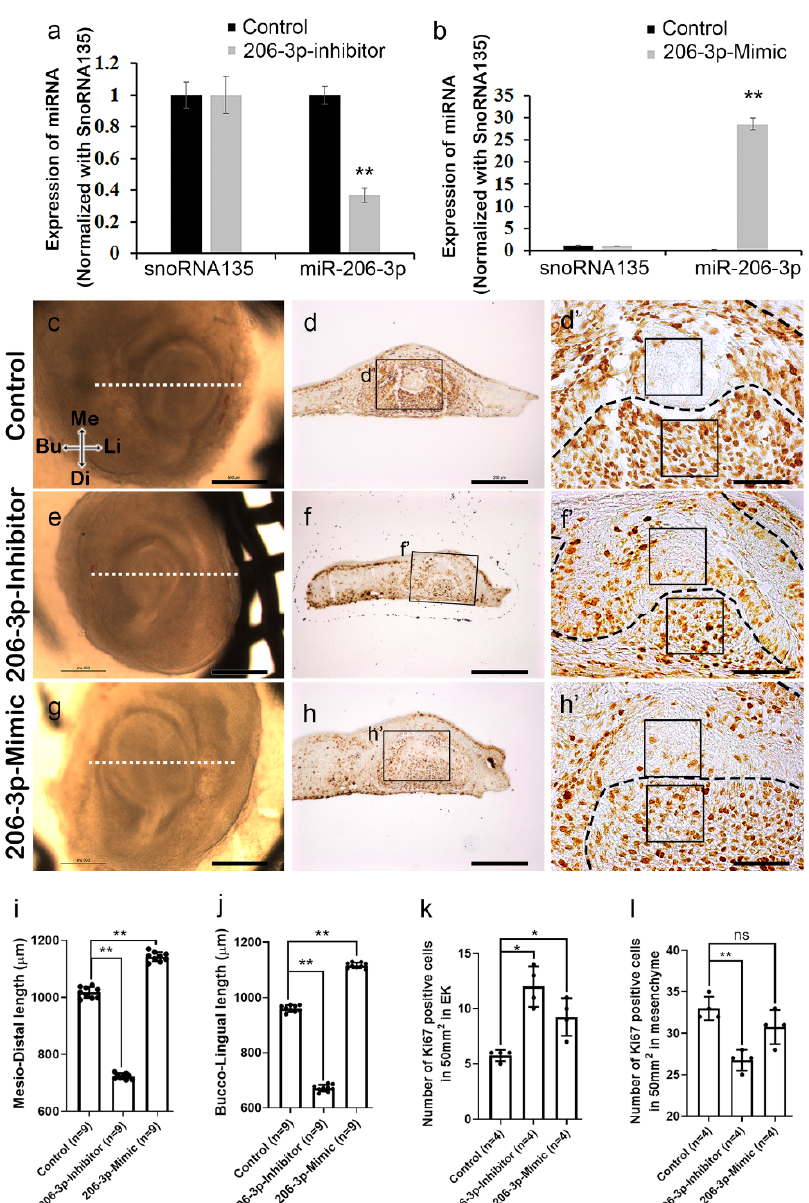
Figure 2. Loss- or gain-of-function of miR-206-3p using organ culture. Inhibitor and mimic significantly altered the expression of miR-206-3p at E13 + 36 h cultivated teeth ( a , b ). Pre–cap-stage developing teeth at E13 were cultivated for 2 days ( c , e , g ). The control specimen showed a proper tooth size and structure after 2 days of cultivation ( c , i , j ). The specimen treated with the inhibitor showed decreased tooth size both bucco-lingually and mesio-distally ( e , i , j ). The mimic-treated specimen showed a larger tooth structure ( g , i , j ) after 2 days of cultivation. In comparison with the control ( d – d’ , k ), cellular proliferation increased in both the inhibitor and mimic treated specimen in EK (50 µ m 2 ) ( f – f’ , h – h’ , k ) and decreased in the mesenchyme ( l ). Bu; buccal, Li; lingual, Me; Mesial, Di; distal, EK; enamel knot. Dotted lines indicate the section levels ( c , e , g ) and epithelial boundary ( d’ , f’ , h’ ), and boxes denote the magnified regions ( d , f , h ) and 50 µ m 2 regions in EK and mesenchyme ( d’ , f’ , h’ ). ns, * and ** indicate not signigicant, p < 0.05 and p < 0.01, respectively. Scale bars 500 µ m ( c , e , g ), 200 µ m ( d , f , h ), 50 µ m ( d’ , f’ , h’ ).